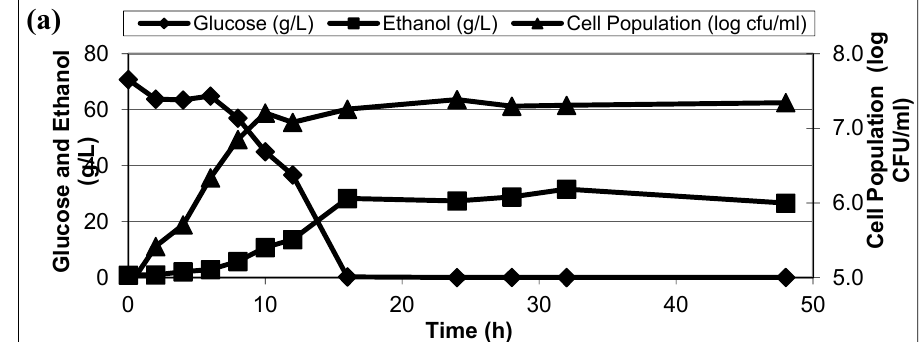
Figure 3. Ethanol, glucose and cell populations in the fermentation broth with different nitrogen sources: Yeast extract ( a ), Feather meal ( b ), Poultry meal ( c ), Meat bone meal ( d ), Hull and fines mix ( e